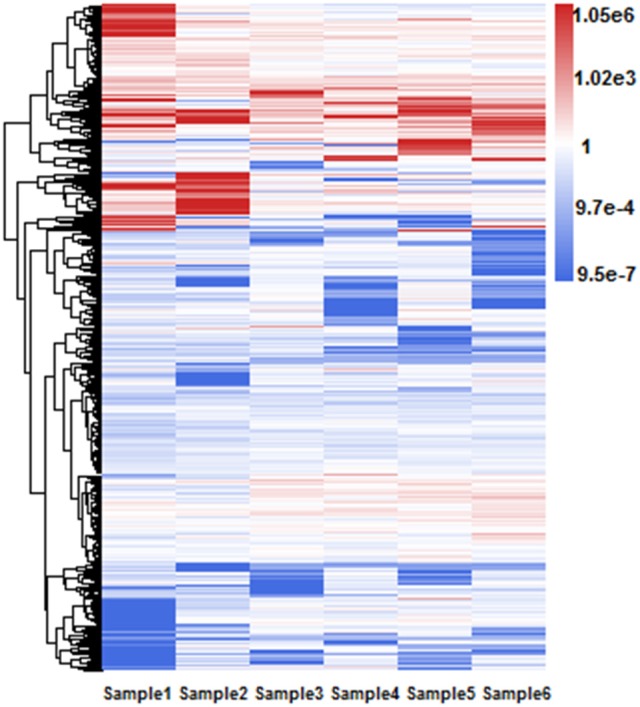
Hierarchical clustering of RI expressional retention odds for all RIs in RI-set-all-expressed. These 968 RIs of RI-set-all-expressed are expressed in all six classes. The blue area means that the expressional retention odds of these RIs < 1.0, while smaller value shows heavier blue color. The red area means the expressional retention odds of these RIs more than 1.0, while larger value shows heavier red color. The white area means that the expressional retention odds of these RIs are equal to 1.0.